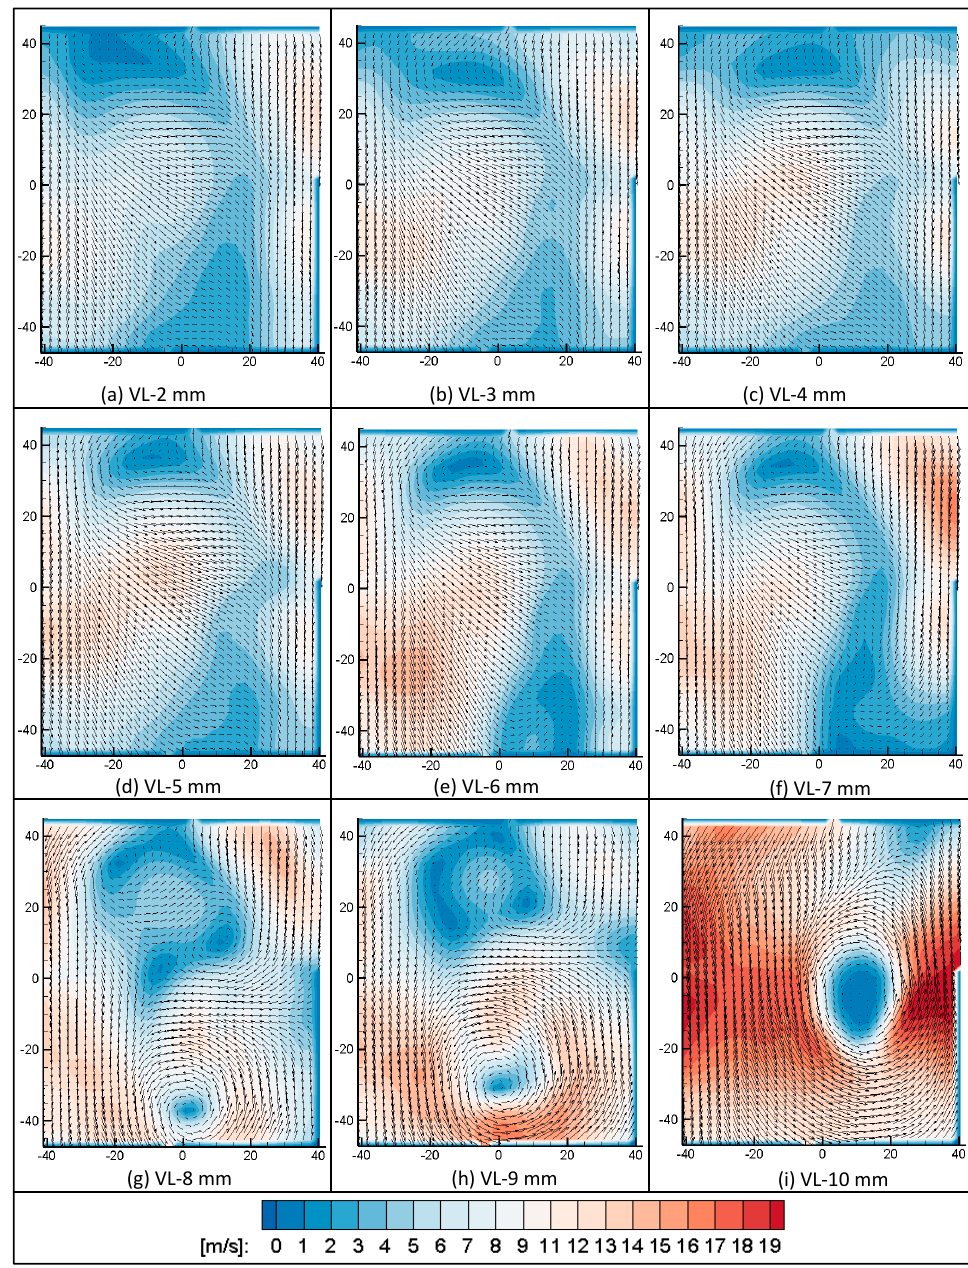
Figure 12. Velocity ensemble average at different valve lifts.